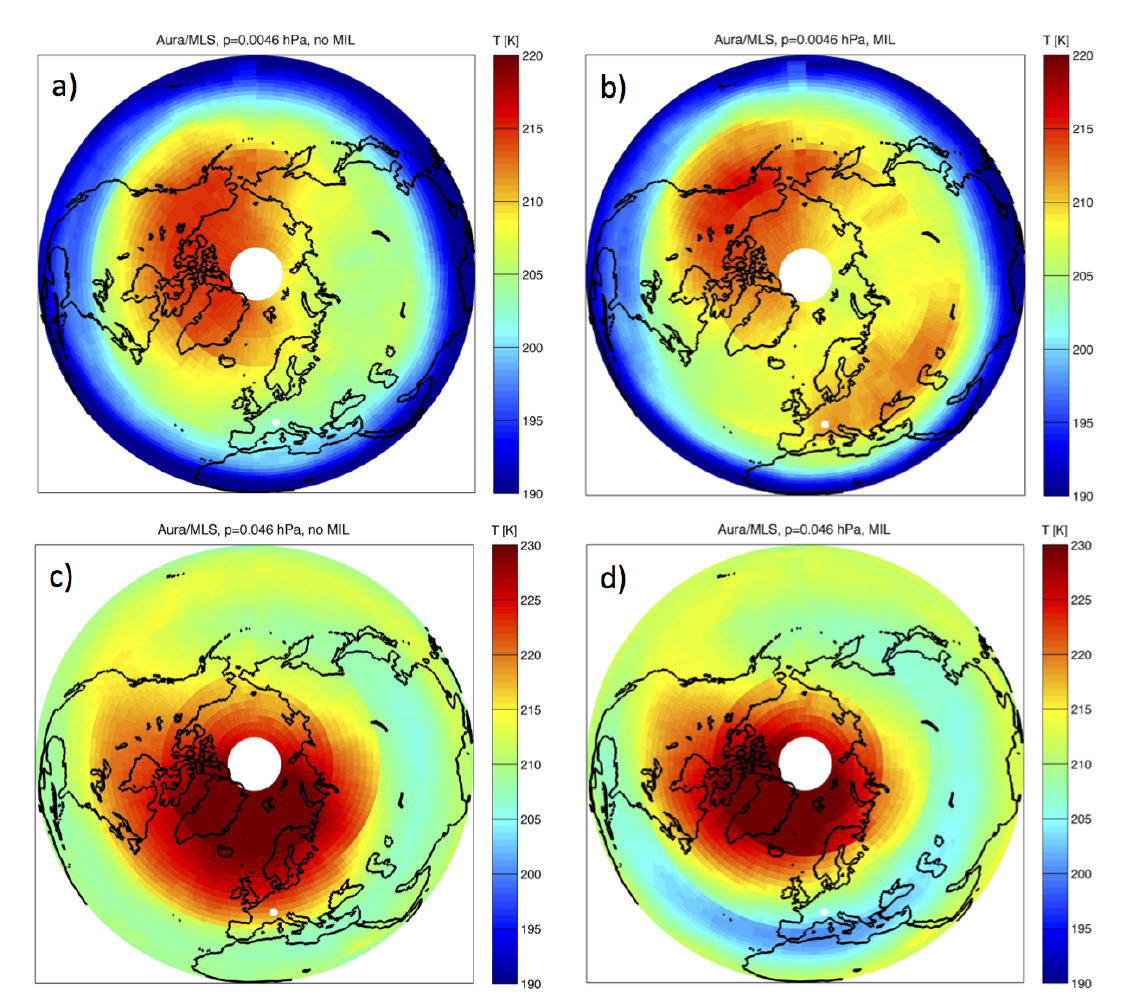
Figure 9. Polar plots of mesospheric temperature observed by Aura/MLS during winter: ( a ) composite at p = 0.0046 hPa when “no MIL” was above Bern; ( b ) composite at p = 0.0046 hPa (at MIL peak) when an “MIL” was above Bern; ( c ) composite at p = 0.046 hPa when “no MIL” was above Bern; ( d ) composite at p = 0.046 hPa (at cold base) when an “MIL” was above Bern. The location of Bern is indicated by the small white